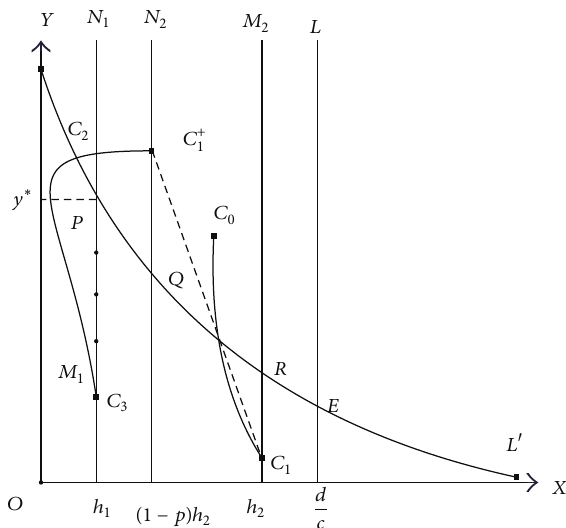
Figure 14: The orbit starting from the point 𝐶 0 (Case 3(a) in Section 4.1.3).